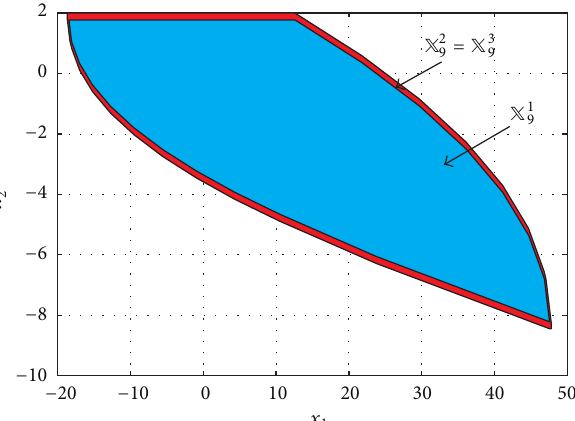
Figure 1: The feasible regions X 1 9 , X 2 9 , and X 3 9 ( 𝑁 = 9 ).